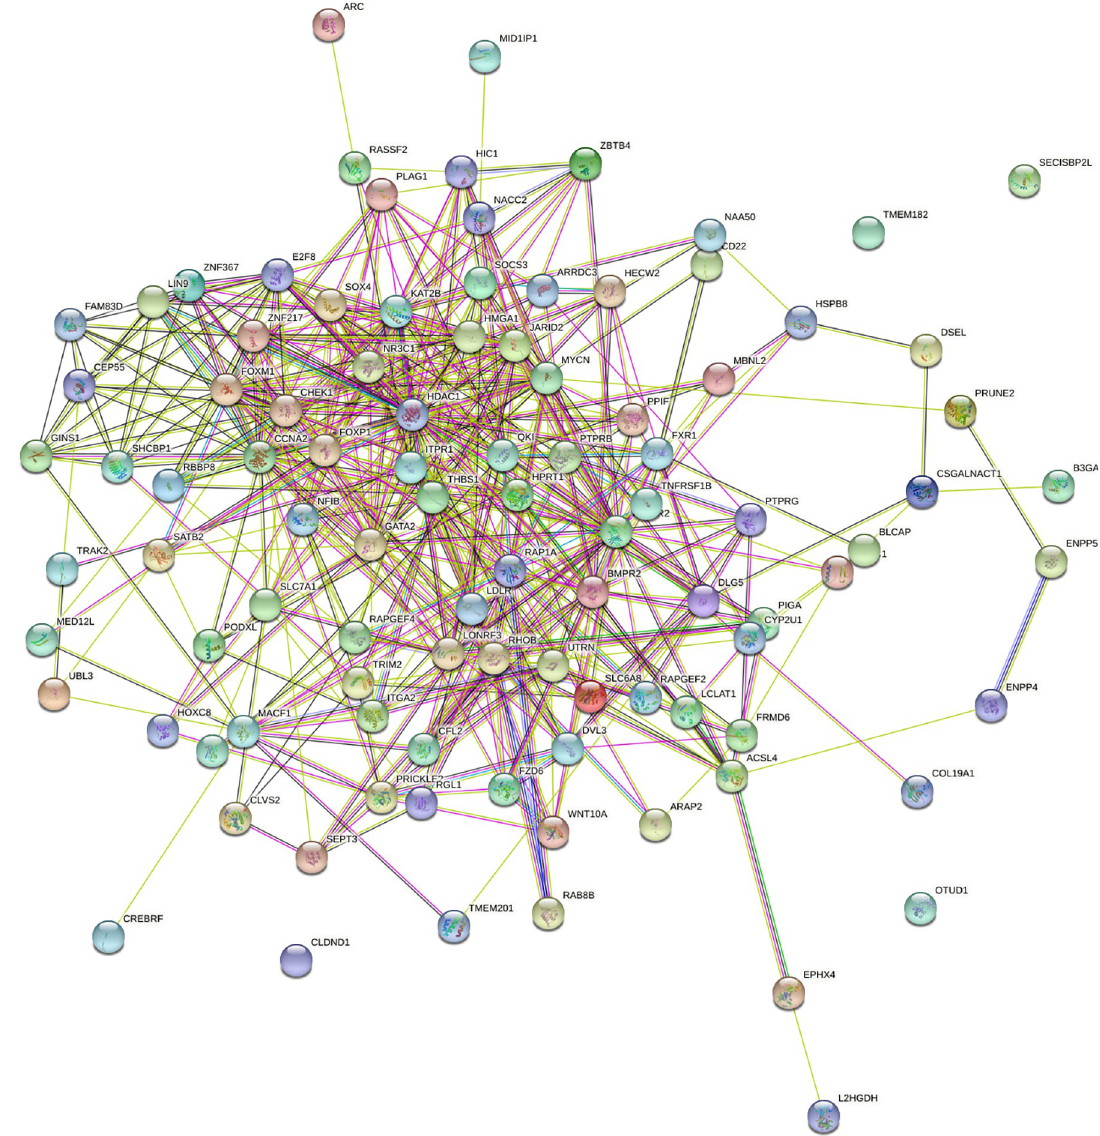
Fig 11. PPI network of LUSC related target